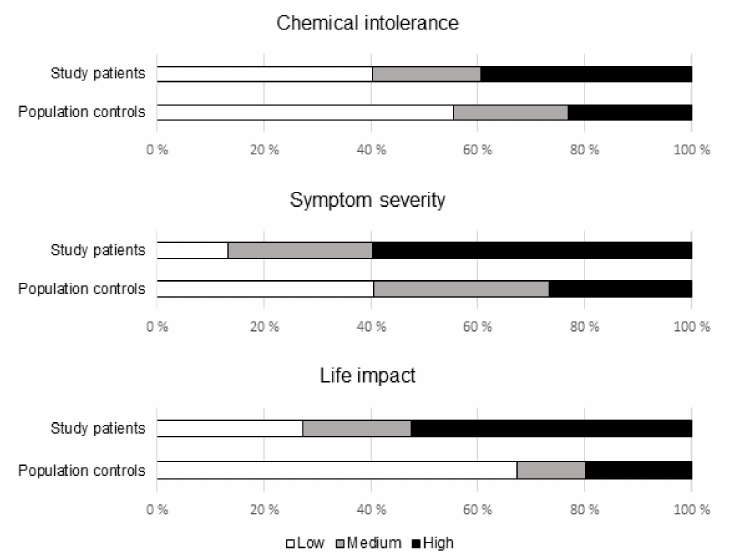
( p = 0.002), symptom severity ( p < 0.001), and life impact ( p < 0.001) among patients and controls (X 2 testing with 3 × 2